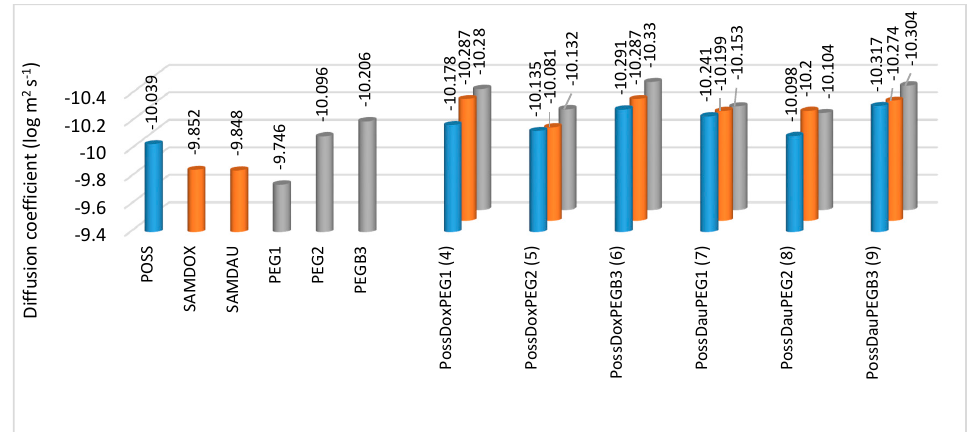
Figure 8. Self-diffusion coefficients (log m 2 s − 1 ) of the SAMDOX, SAMDAU, POSS(OH) 32 , PEG1, PEG2, PEGB3 and conjugates 4 – 9 from the resonance signals: POSS (1.45 ppm), SAMDOX (7.84 ppm), SAMDAU (7.79 ppm), PEG1 (2.43 ppm), PEG2 (3.49 ppm), PEGB3 (3.48 ppm), PossDoxPEG1 (1.42 ppm; 7.85 ppm; 2.43 ppm), PossDoxPEG2 (1.42 ppm; 7.83 ppm; 3.49 ppm), PossDoxPEGB3 (1.47 ppm; 7.84 ppm; 3.43 ppm), PossDauPEG1 (1.45 ppm; 7.79 ppm; 2.42 ppm), PossDauPEG2 (1.49 ppm; 7.78 ppm; 3.52 ppm) and PossDauPEGB3 (1.49 ppm; 7.82 ppm; 3.51 ppm).